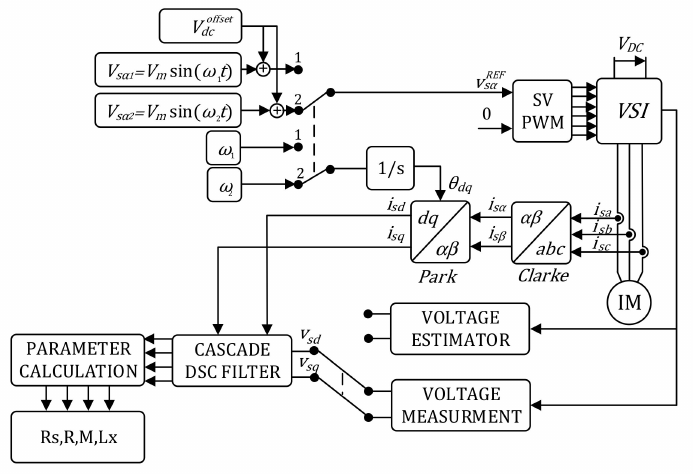
Figure 5. Experimental configuration for the implementation of the technique with two sinusoidal voltage test